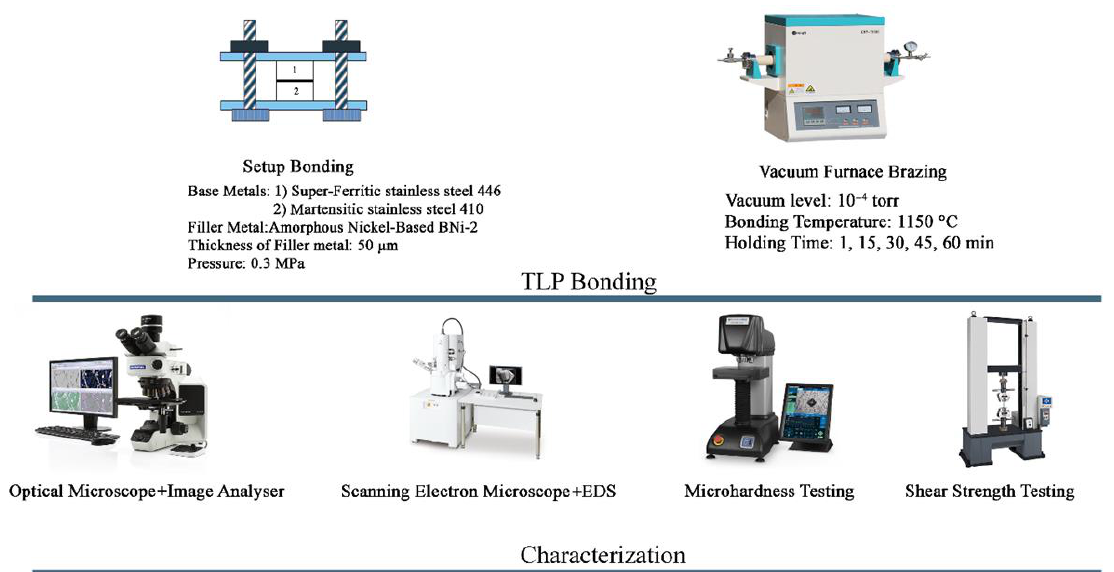
Figure 2. Schematic of experimental setup of the diffusion bonding processes of super-ferritic and martensitic stainless steel by BNi-2 amorphous foil.